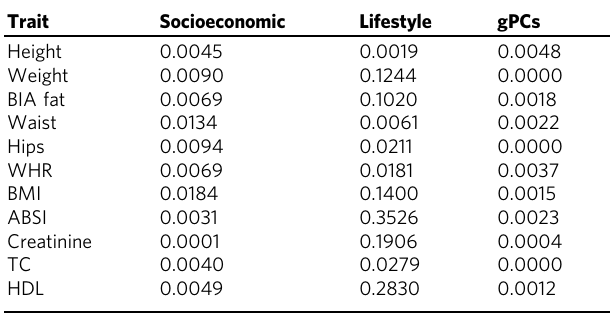
Table 3 Proportion of the phenotypic variance explained by the covariates in the Benchmark Structure +